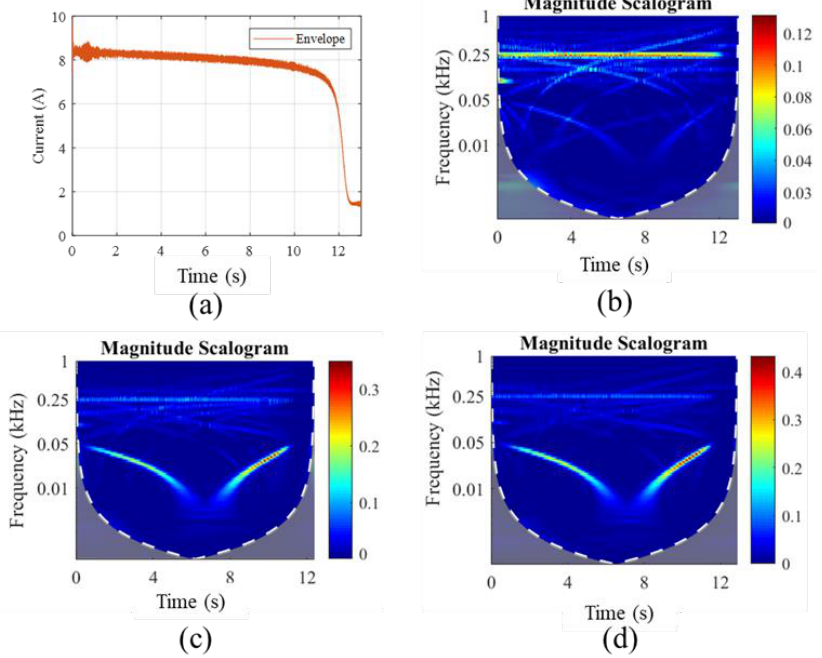
Figure 12. The results based on the measurements taken at 10% of the rated supply voltage. ( a ) The envelope of the motor’s phase current in the transient regime. ( b ) Time–frequency spectrum in the healthy case with an attenuated fundamental component. ( c ) Time–frequency spectrum in the case of one broken bar with the attenuated fundamental component. ( d ) Time–frequency spectrum in the case of two broken bar with an attenuated fundamental